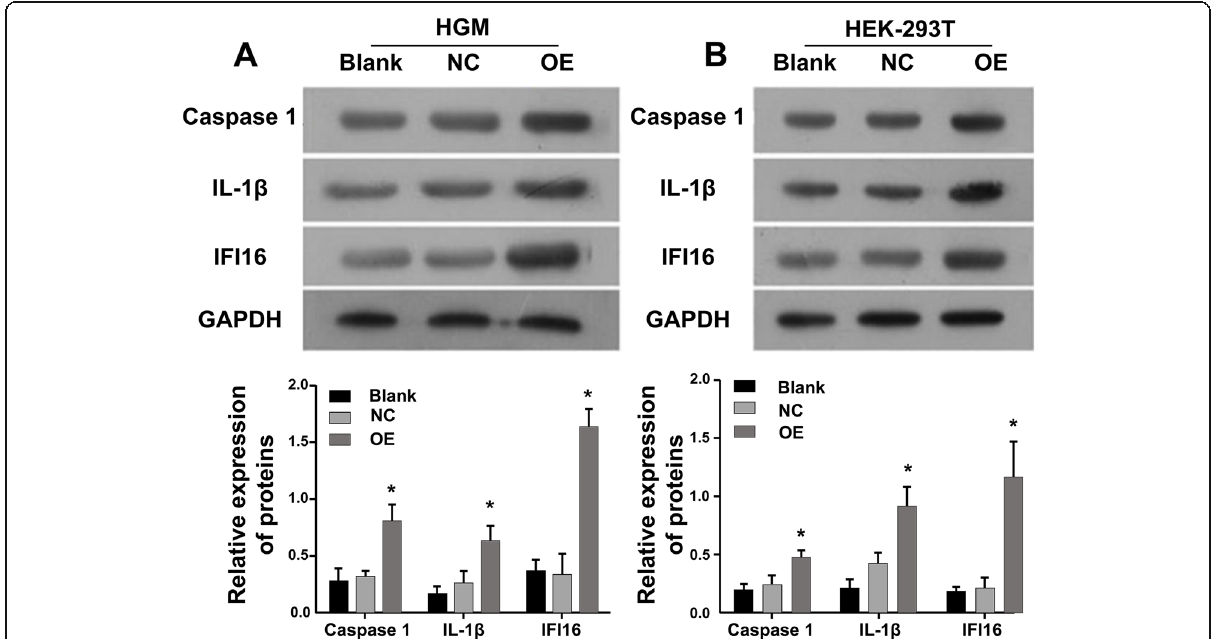
Fig. 3 The expression of IFI16, Caspase-1 and IL-1ß protein levels significantly elevated in OE group compared those in NC and Blank group of the two cell lines,